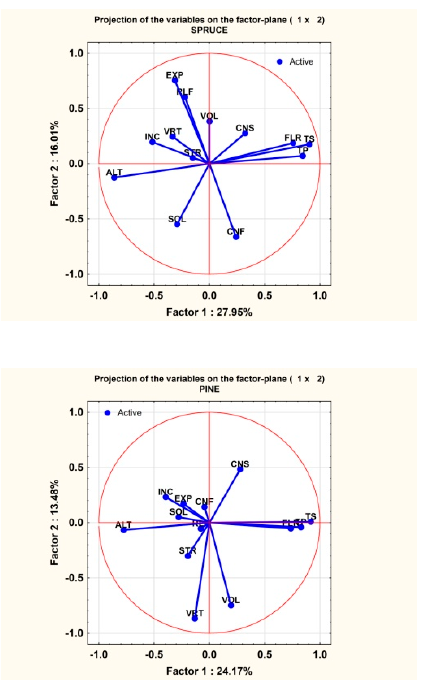
Figure 7. PCA diagram for factors 1 and 2.